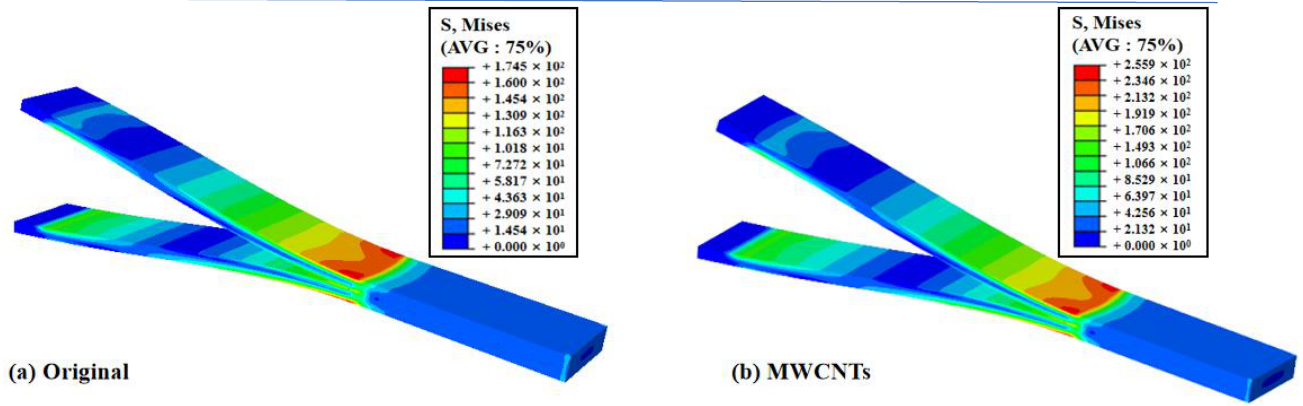
Figure 9. The deformation contour of the original specimens and the MWCNTs toughening specimens.